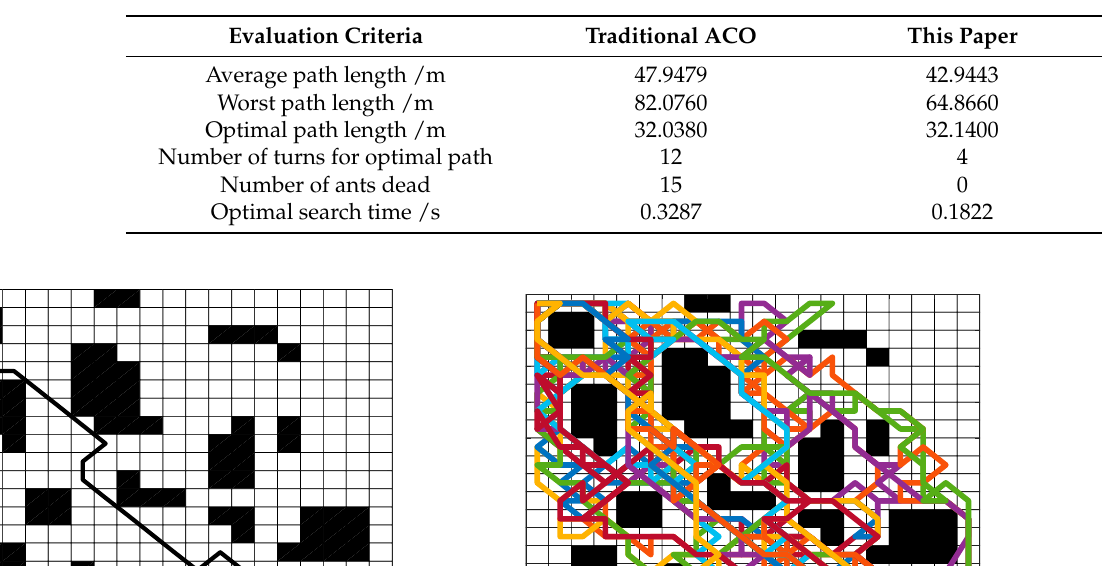
Table 1. Initial population algorithm performance comparison table.